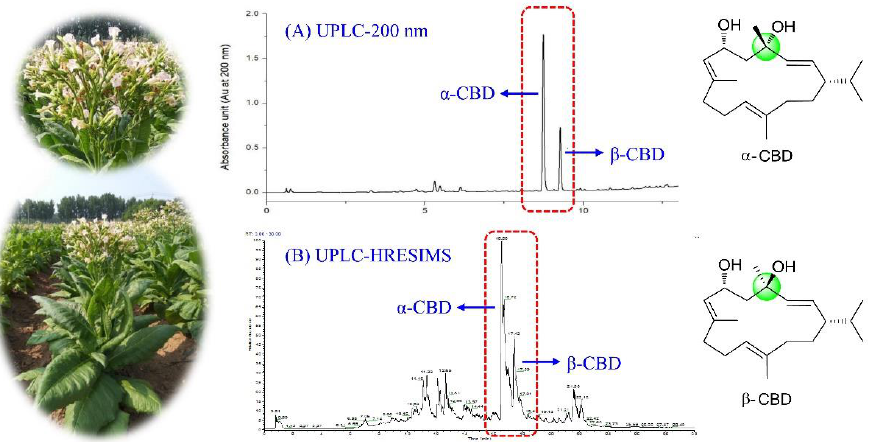
Figure 1. UPLC ( A ) and HPLC-HRESIMS ( B ) analyses of α -CBD and β -CBD in tobacco glandular trichome secretions.